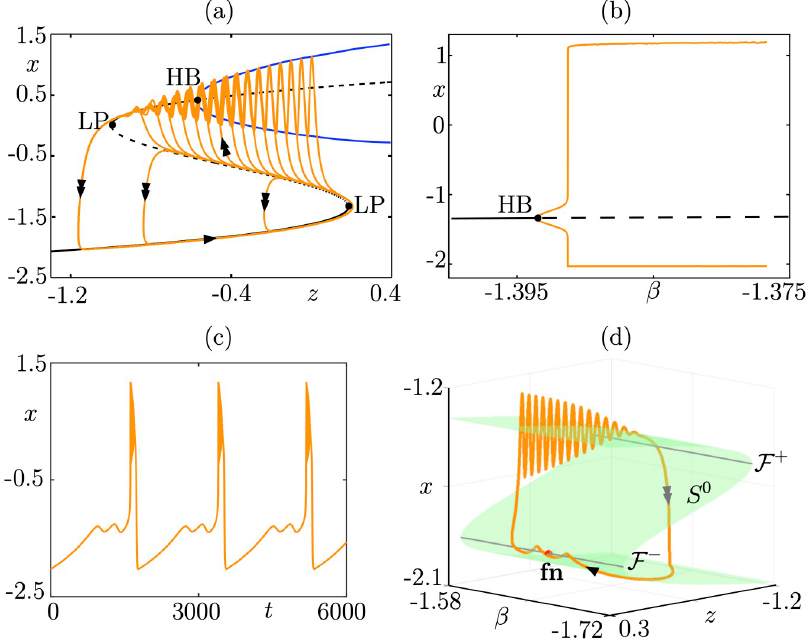
Fig 9. Folded-node/Hopf bursting. Panels (a-b) show the spike-adding transition in system (1): (a) in the ( z , x ) plane where we show several limit cycles for β -values exponentially close to − 1.391279 superimposed onto the fast subsystem bifurcation diagram; (b) bifurcation diagram of the associated 3D bursting system (1) with respect to parameter β , showing the sharp rise of the amplitude of the limit cycle branch (orange), corresponding to spike-adding transitions. Panels (c-d) show a folded-node/Hopf bursting orbit in the extended 4D system (6): (c) in the ( β , z , x ) space (single/ double arrows indicate slow/fast motion); (d) time course of the fast variable x . Equations and parameter values are given in S1